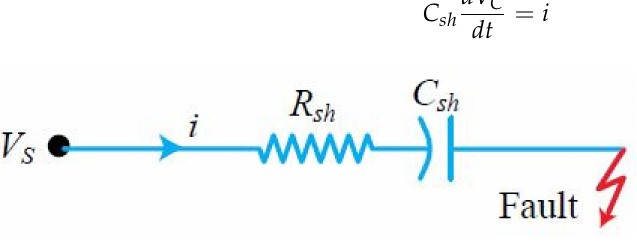
Figure 14. Off-state equivalent CBFCL in DFIG and PMSG wind